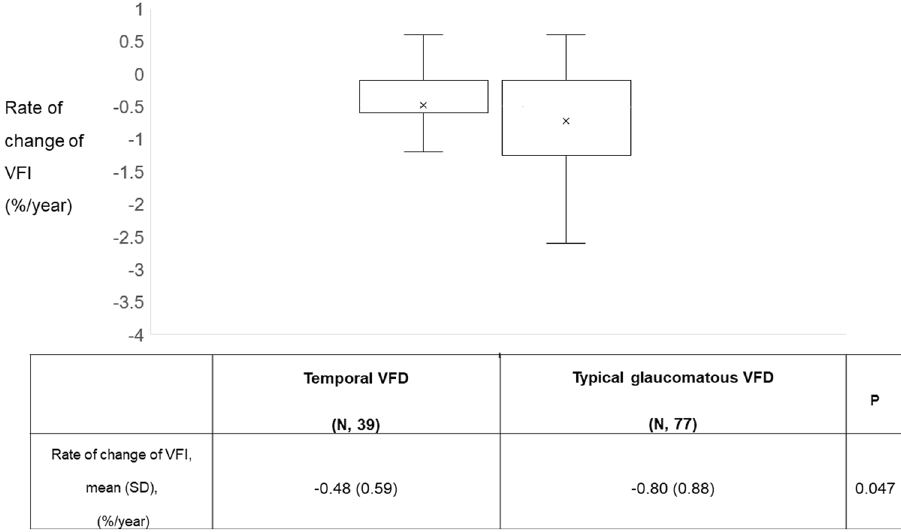
Figure 2. Glaucoma progression analysis using assessment with Trend- based analysis. Mean values of the rate of change of VFI (%/year) are shown. VFD indicates visual field defect; VFI, visual field index. Bold font indicates significant P values ( P < 0.05). X in the box stands for the mean value for each group.